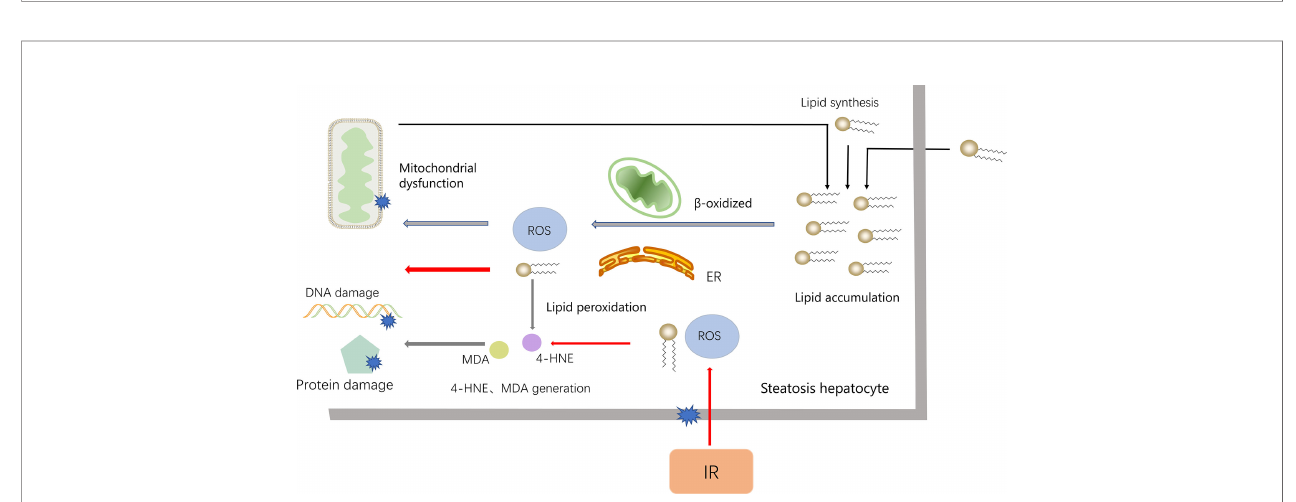
FIGURE 5 | The accumulation of lipids is an important reason for the NAFLD. To process the accumulated lipids, hepatocytes increase mitochondrial b -oxidation and the activity of ER, which lead to the synthesis of ROS. ROS, in turn, damages the mitochondria, further leading to the accumulation of fatty acids (black arrows). When NAFLD encounters IR, ROS increased (red arrow), combined to accumulated fatty acids and release 4-HNE and MDA, which cause DNA and protein damage and worsen liver